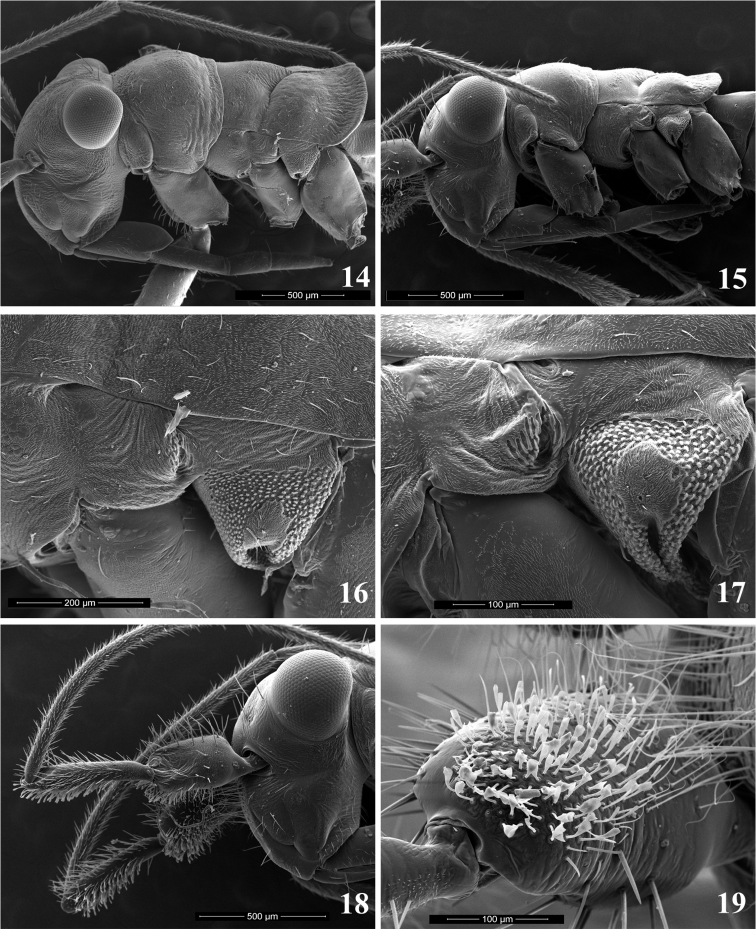
Scanning electron micrographs. 14, 15 Head and thorax in lateral view 14Myrmecophyesarmeniacus Drapolyuk, 1989, female 15Myrmecophyesheterocerus Horváth, 1927, male 16, 17 Metathoracic scent gland evaporative area and spiracle 16M.armeniacus17M.heterocerus18 Head of M.heterocerus male in lateral view 19 Antennal segment I of M.heterocerus male.